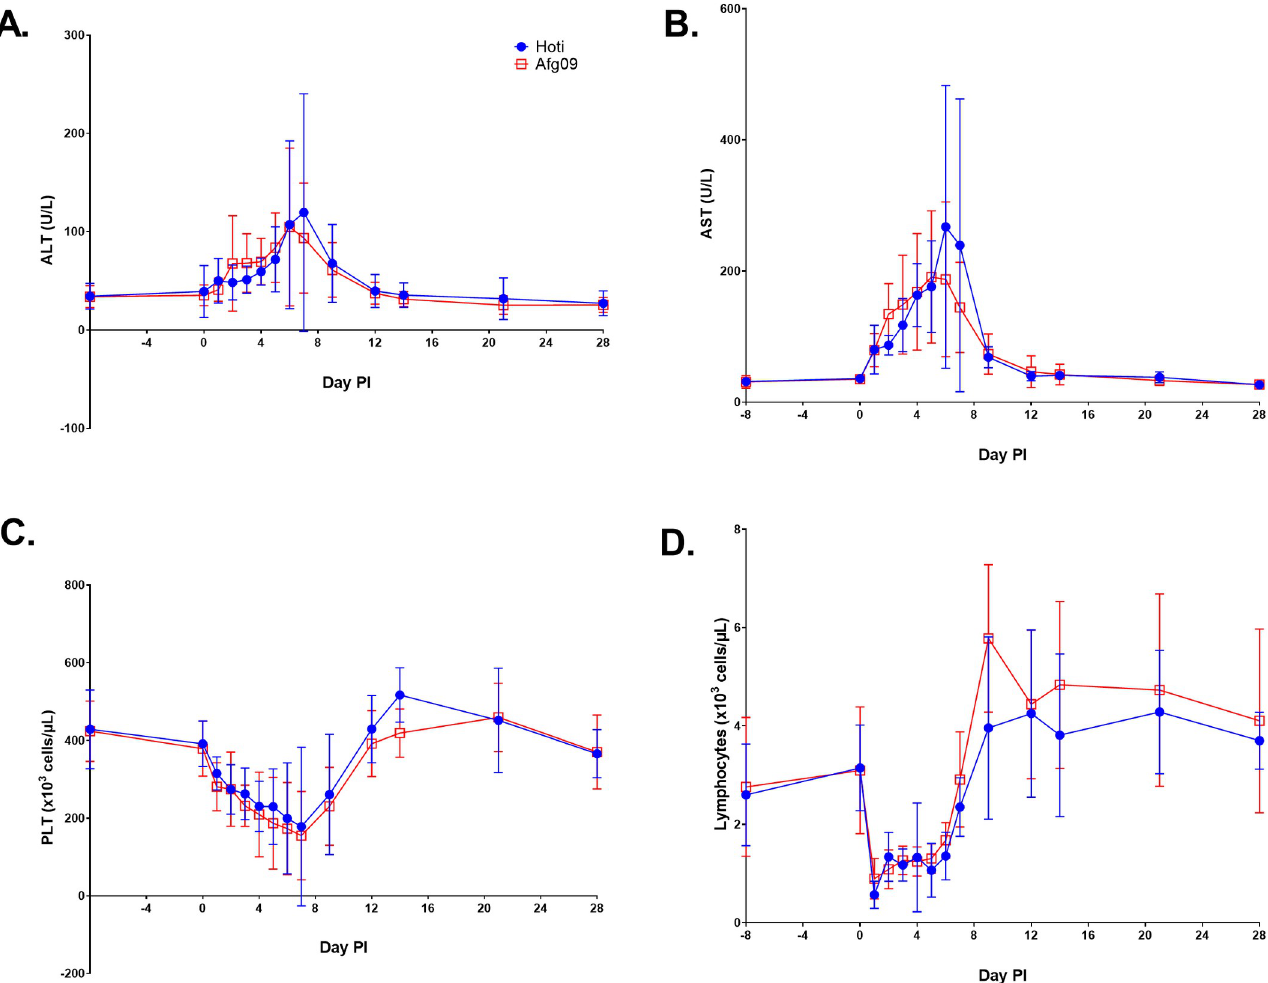
Fig 2. Blood chemistry and hematology results in cynomolgus macaques infected IV with CCHFV strain Hoti or Afg09. A) ALT. B) AST. C) PLT. D) Lymphocytes. The symbols represent the mean value and the error bars represent the standard error of the mean.